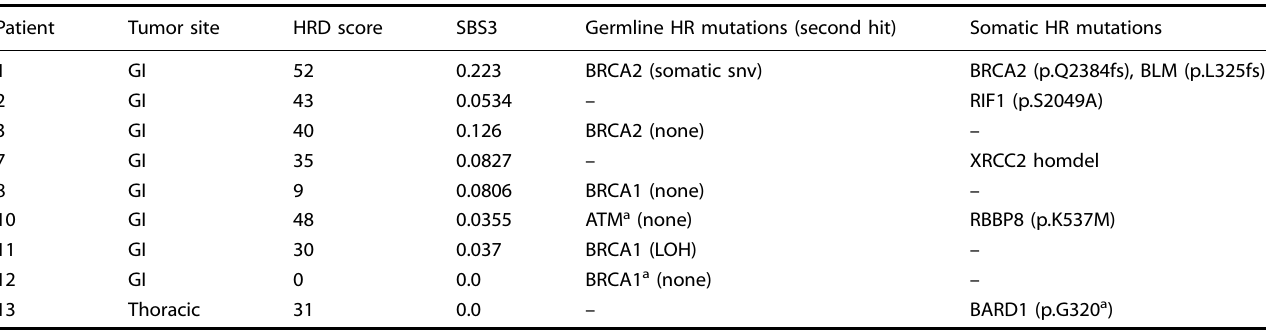
Table 3. HR mutations among patients with HRD as identi fi ed by HRDetect.